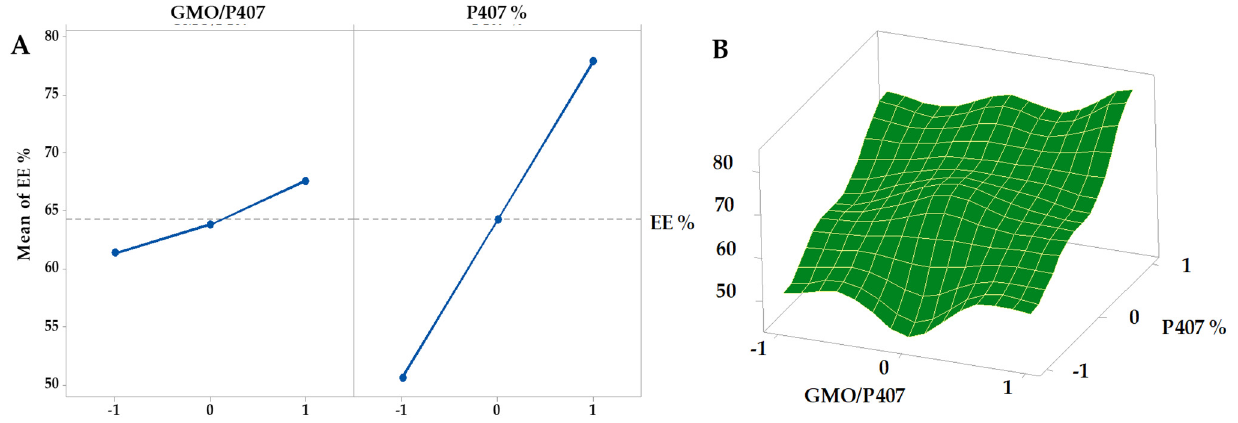
Figure 6. Main effects ( A ) and response surface plots ( B ) of GMO/P407 and P407% on EE%.